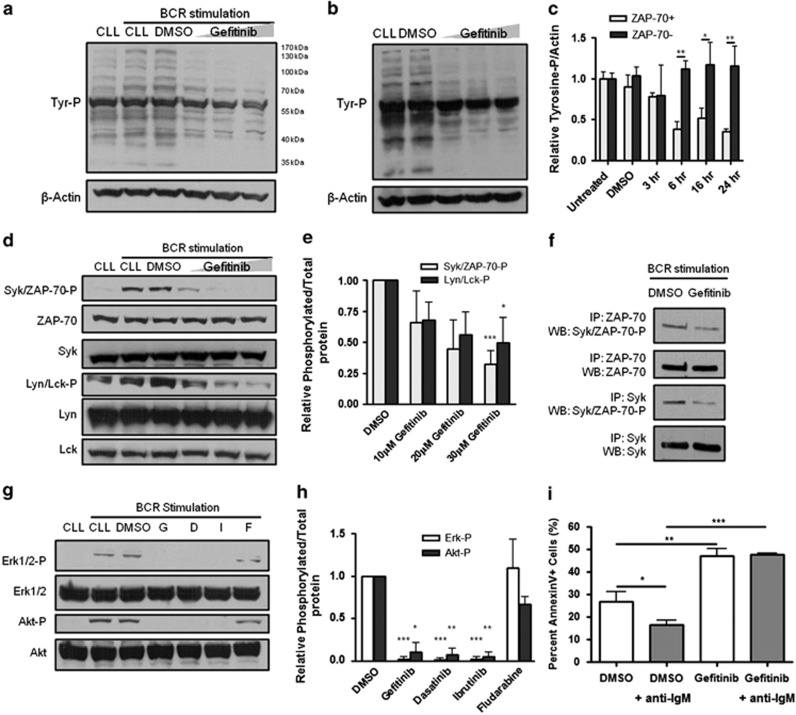
Gefitinib targets BCR pathway and inhibits survival response. Primary ZAP-70+ CLL cells were treated with DMSO, and 10, 20, or 30 μM gefitinib, and stimulated with anti-IgM (a) or left unstimulated (b). Lysates were collected after 1 h and analyzed for tyrosine phosphorylation by western blot. The experiment was repeated with three different patient samples. (c) Lysates of a ZAP-70+ and a ZAP-70− CLL patient sample treated with 10 μM gefitinib for 3, 6, 16, and 24 h analyzed by slot blot for tyrosine phosphorylation (unpaired t-test). (d) ZAP-70+ CLL cells were treated with DMSO, and 10, 20, or 30 μM gefitinib, and stimulated with anti-IgM. Lysates were collected after 1 h and analyzed for ZAP-70/Syk and Lyn/Lck phosphorylation by western blot. The experiment was repeated with four different ZAP-70+ CLL samples, all of which were compared using densitometry (e) calculated using ImageJ. Densitometry values of phosphorylated Syk/ZAP-70 or Lyn/Lck first normalized to DMSO, and then to total protein. (f) Immunoprecipitation of ZAP-70 and Syk from a primary CLL patient sample and analyzed for tyrosine phosphorylation by western blot after 1 h of 30 μM gefitinib treatment. Representative of n=3 is quantified in Supplementary Figure 6. (g) ZAP-70+ CLL cells were treated with DMSO, 30 μM gefitinib (lane G), 10 μM dasatinib (lane D), 10 μM ibrutinib (lane I), or 10 μM fludarabine (lane F) and stimulated with anti-IgM. The experiment was repeated in two different ZAP-70+ CLL samples and compared using densitometry (h). Lysates were collected after 1 h and analyzed for ERK1/2 and Akt phosphorylation by western blot. The experiment was repeated with two different patient samples. (i) ZAP-70+ CLL sample was pretreated with 10 μM gefitinib for 30 min, stimulated with plate-immobilized anti-IgM for 30 min, and cultured for 24 h. Samples were stained with Annexin V-FITC and analyzed by flow cytometry (unpaired t-test). Single representative experiment done in triplicate with S.D. is shown. The experiment repeated with three different patient samples. *P<0.05, **P<0.01, or ***P<0.001